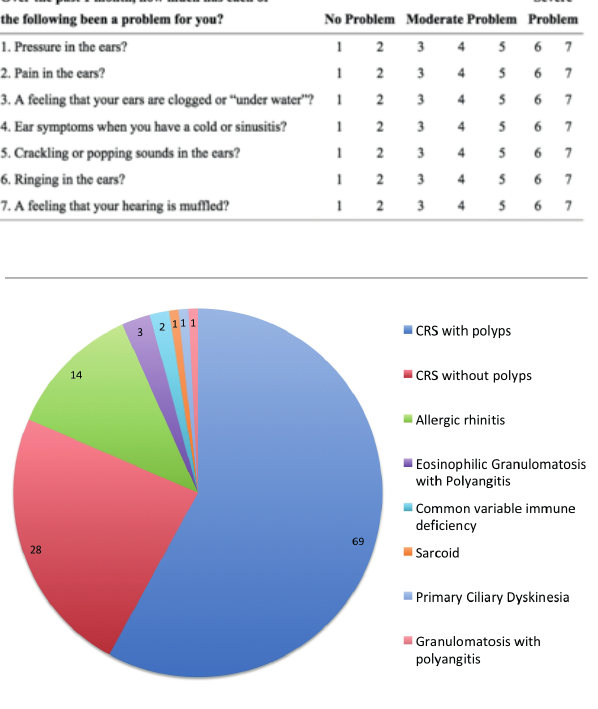
Figure 1. Distribution of pathology within the rhinology patient